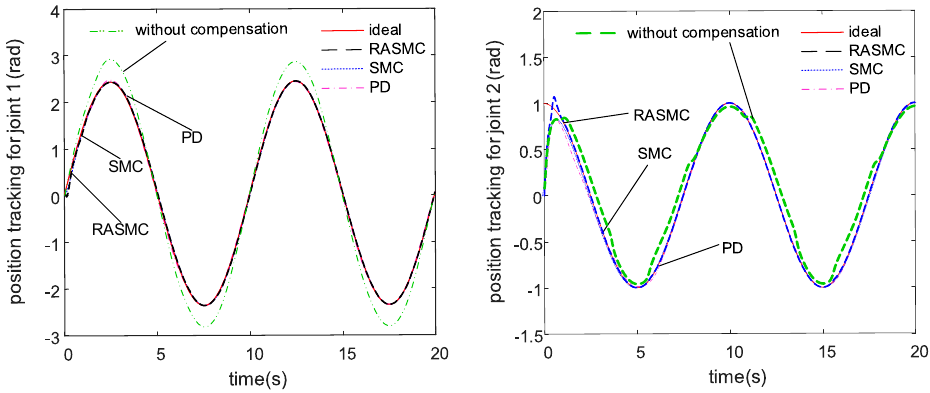
Figure 9. Position tracking performance of joint 1 ( left ) and joint 2 ( right ).